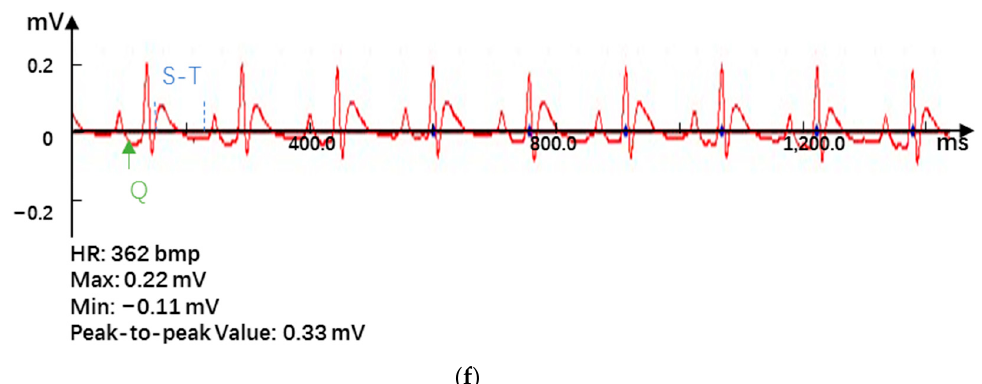
Figure 4. Electrocardiogram results in ( a ) the sham group, ( b ) the model group, ( c ) the positive drug group, ( d ) the miR-133 group, ( e ) the PEG-PLA/miR-133 group, and ( f ) the RGD-PEG-PLA/miR-133 group of